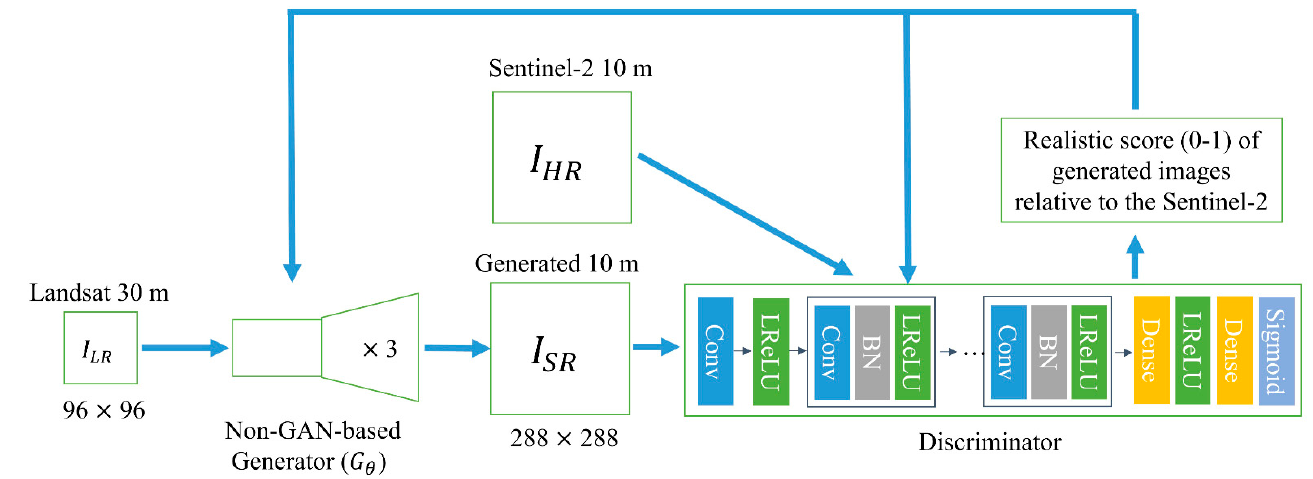
Figure 2. The architecture of GAN-based models.